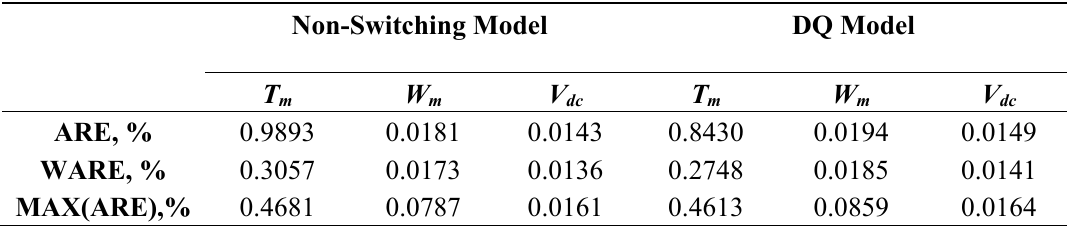
Table 1. Numerical analysis of error for Non-switching and DQ